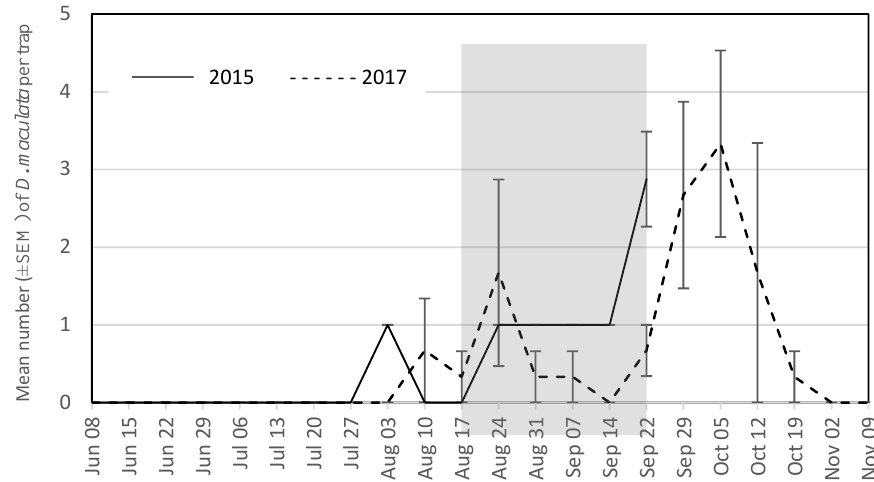
Figure 5. Mean number ( ± SEM) of Dolichovespula maculata caught per trap per week in South Central Wisconsin vineyards in traps baited with acetic acid and isobutanol (AAIB) from 8 June to 22 September 2015 (solid line) and from 8 June to 9 November 2017 (dashed line). The shaded region indicates the overall grape harvest for all grape cultivars present across all vineyards sampled.